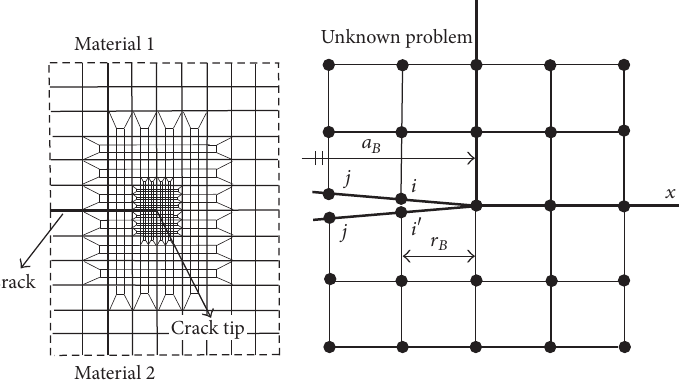
Figure 3: Finite element idealization around the crack